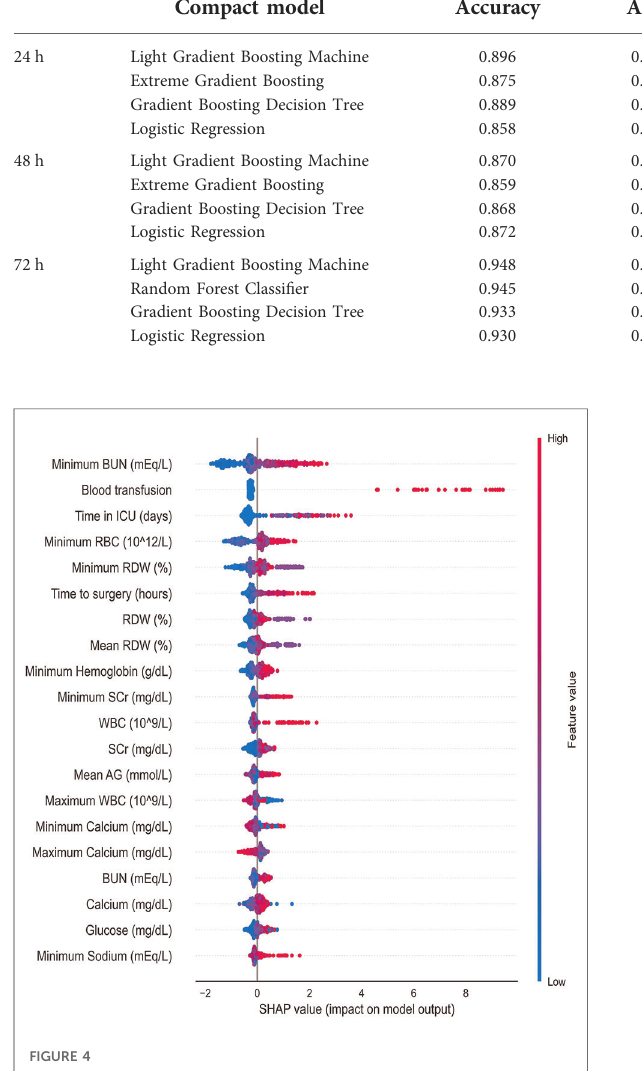
FIGURE 4 Distribution of the impact that each feature has on the full 24 h prediction model output estimated using the SHapley Additive exPlanations (SHAP) values. The plot sorts features by the sum of SHAP value magnitudes over all samples. The color represents the feature value (red high, blue low). The x axis measures the impact on the model output (right positive, left negative). BUN, blood urea nitrogen; ICU, intensive care unit; RBC, red blood cell; RDW, red blood cell distribution width; SCr, serum creatinine, WBC, white blood cell count; AG, anion